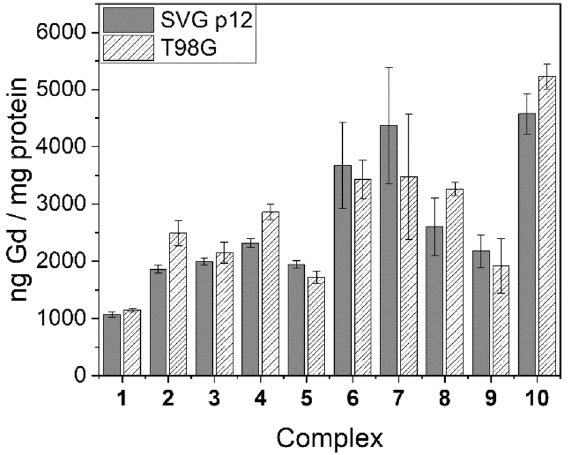
Figure 5. Cell uptake values for complexes 1 – 10 in SVG p12 and T98G cell lines at 500 μM.